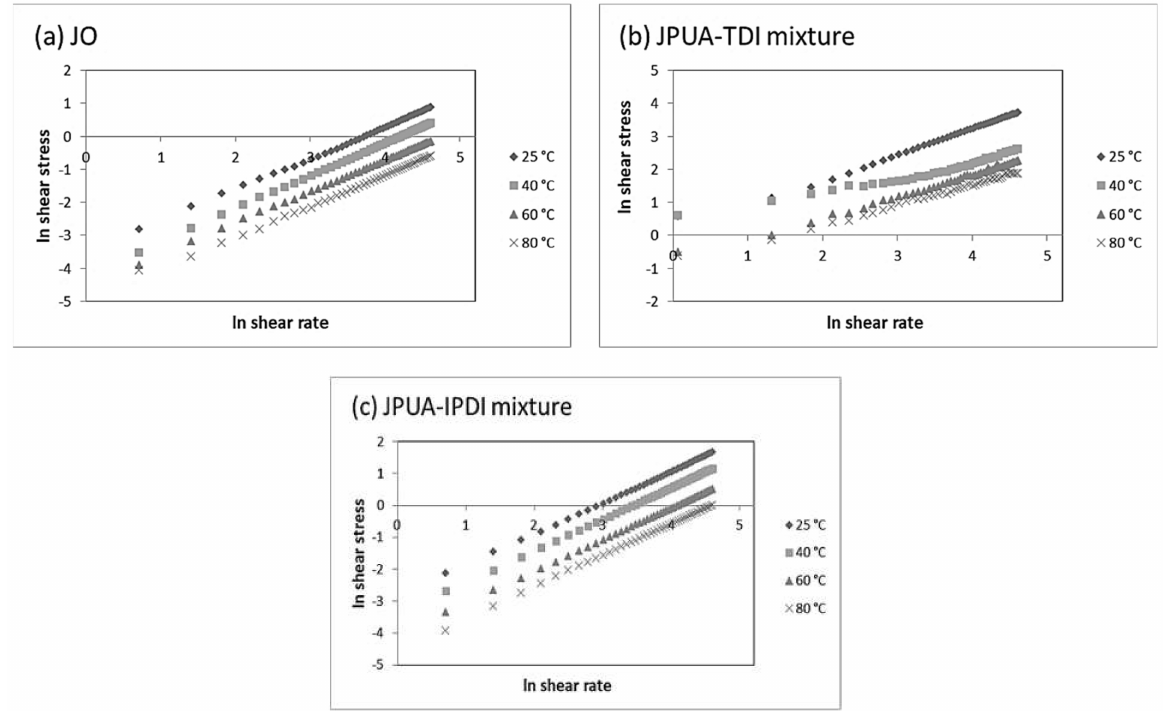
Figure 6. Graph of ln shear stress versus ln shear rate of ( a ) JO, ( b ) JPUA-TDI mixture and ( c ) JPUA-IPDI mixture. Table 4. Power law fluid properties of JO, JPUA-TDI mixture and JPUA-IPDI mixture at four different temperatures.